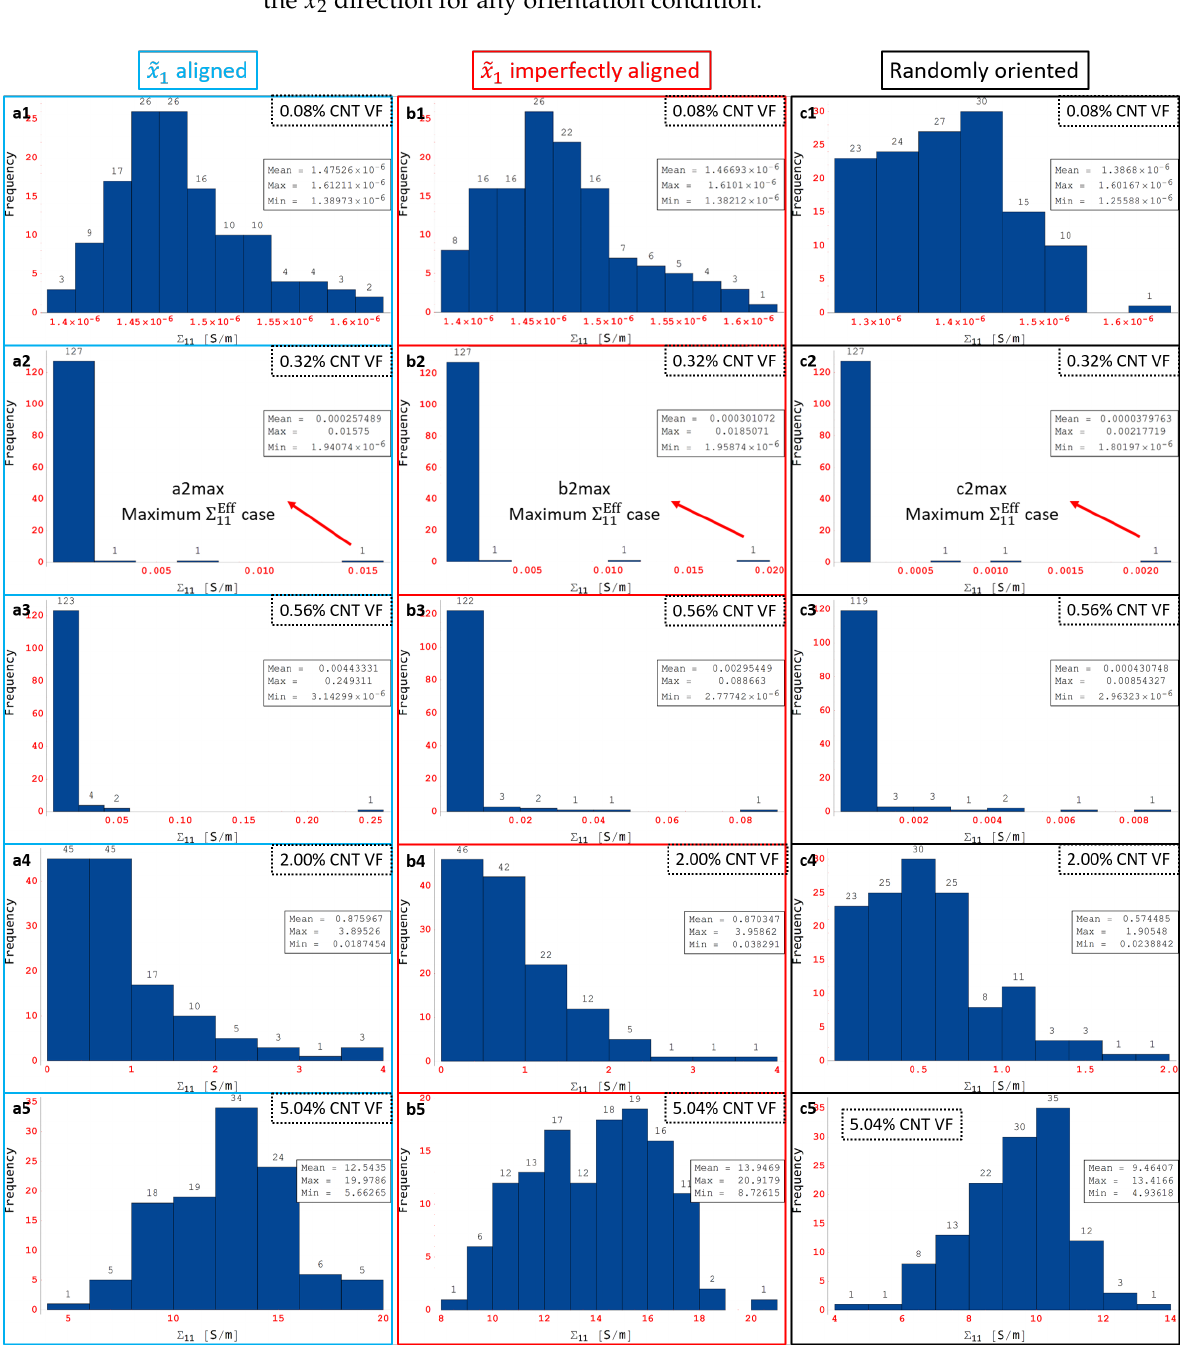
Figure 17. Histograms for Σ 11 at 0.08%, 0.32%, 0.56%, 2.00% and 5.04% CNT volume fractions for all orientation